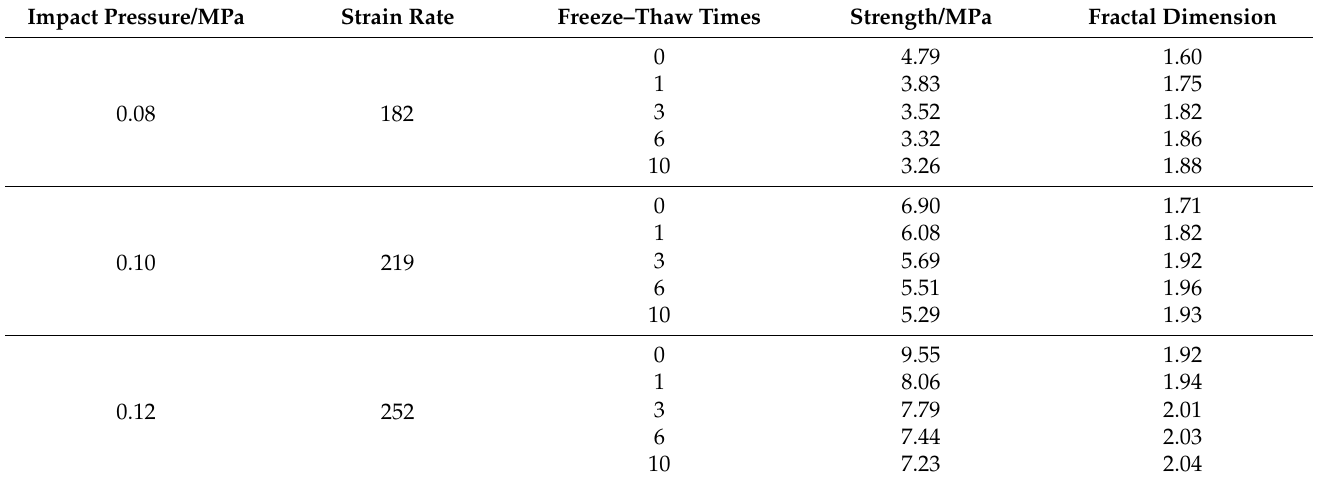
Table 4. Summary of test results.